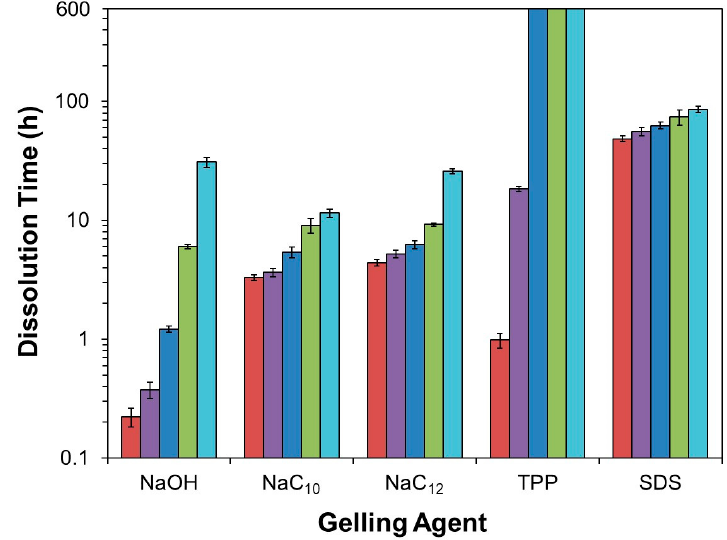
Figure 2. Summary of bead dissolution times in 10 mM aqueous NaCl solutions at pH ( (cid:4) ) 1.2, ( (cid:4) ) 2.0, ( (cid:4) ) 3.0, ( (cid:4) ) 4.0, and ( (cid:4) ) 5.0, increasing in this plot from left to right. The bars reaching the top of the plot for the chitosan/TPP beads at pH 3.0–5.0 indicate that these beads remained intact throughout the entire experiment. For all other conditions, error bars representing one standard deviation in bead dissolution time are given ( n = 6).